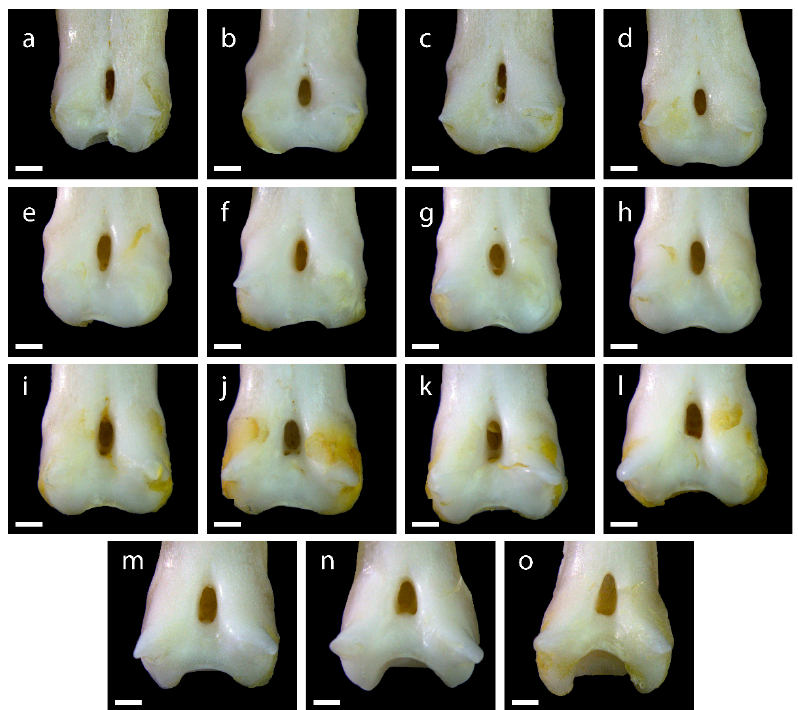
Figure A5. Microscopic images of the posterior view of the pinnules of P. bichir PO6. The images ( a – o ) correspond to the 1st, 2nd, 3rd, 4th, 5th, 6th, 7th, 8th, 9th, 10th, 11th, 12th, 13th, 14th, and 15th pinnules, respectively. Scale bars = 1 mm.